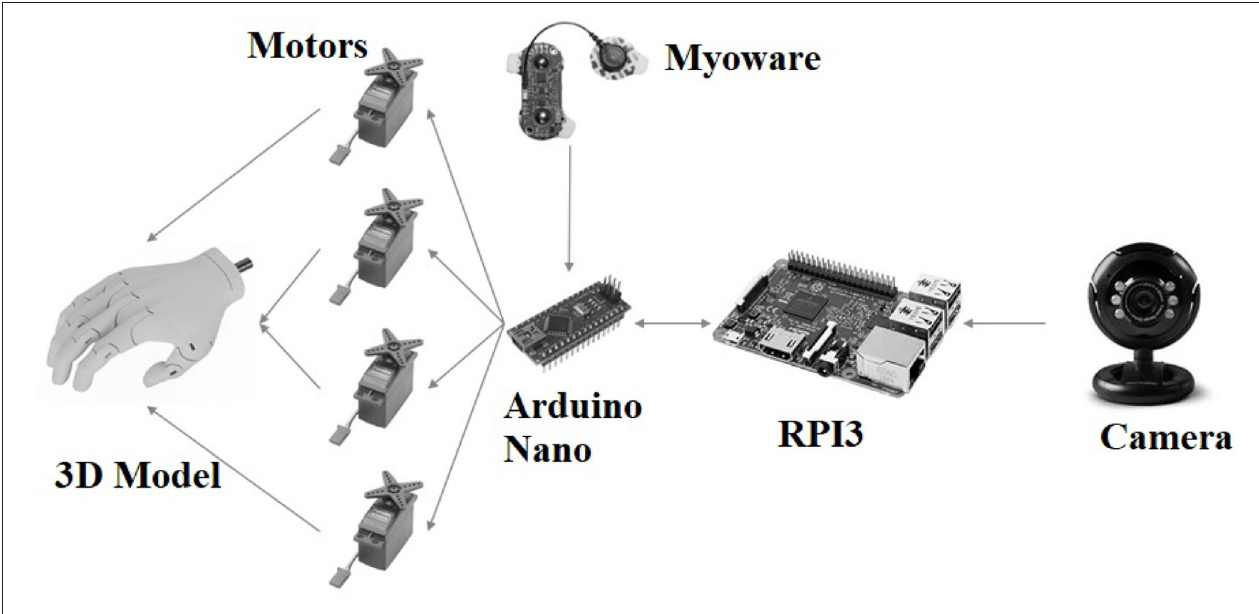
FIGURE 1 | Prosthesis prototype diagram system.